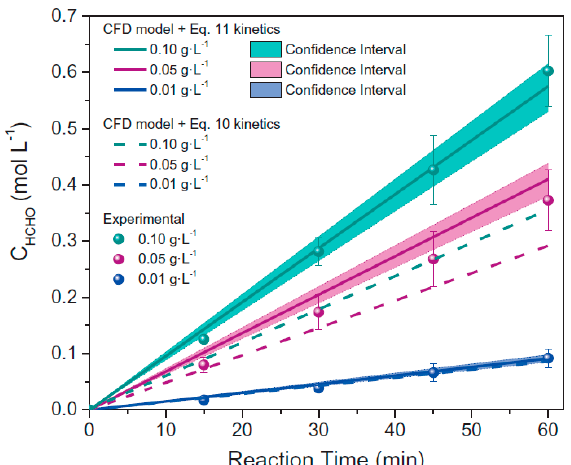
Figure 7. Validation of CFD simulation results for an annular laboratory-scale photoreactor with experimental data using different photocatalyst loadings (0.01, 0.05, and 0.1 g L − 1 ). Reprinted with permission from [83]. Copyright Elsevier, 2017.